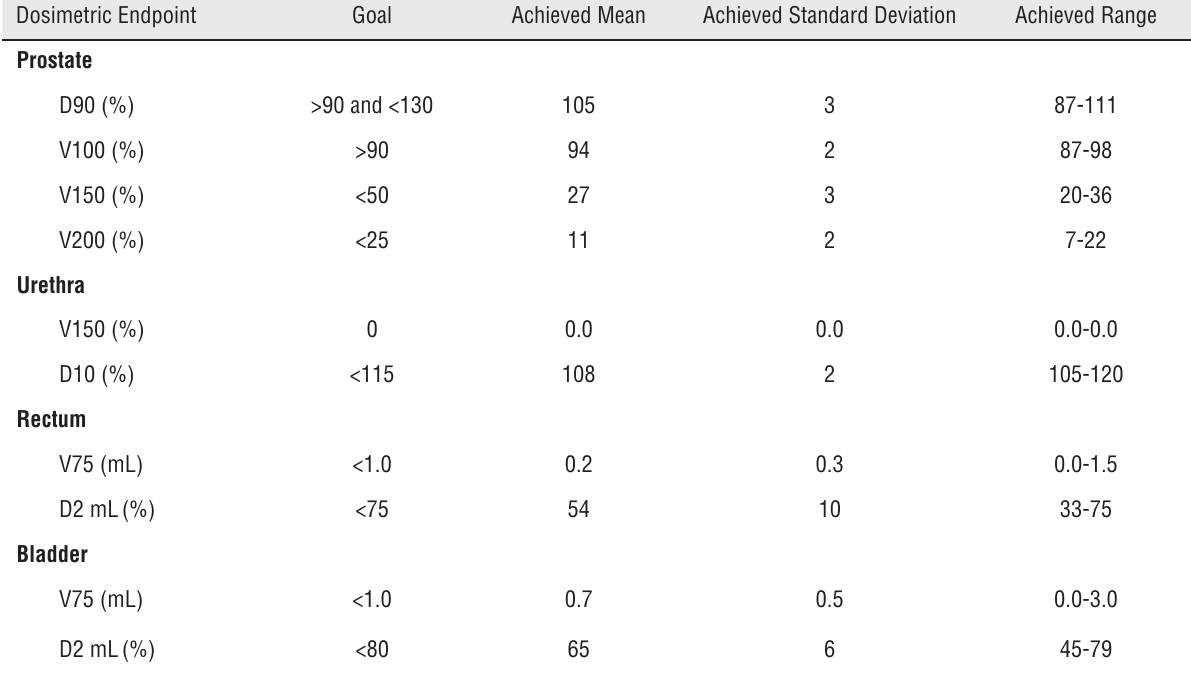
Table 2 - Dosimetric results achieved with HDR brachytherapy. Dosimetric